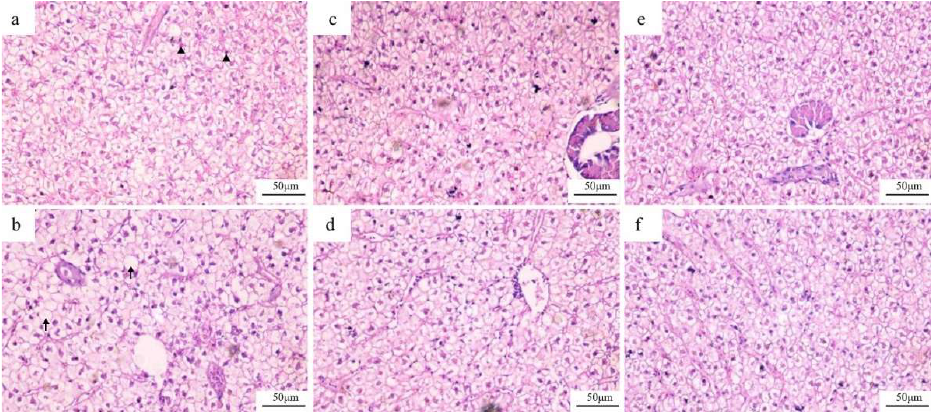
Figure 1. Effect of common reed on liver histology of grass carp (200 times). ( a , b ): 0% replacement group; ( c , d ): 50% replacement group; ( e , f ): 100% replacement group. The triangle in the figure indicates lymphocyte cells, and the arrow indicates vacuolar degeneration of cells. Table 5. Histological parameters of liver from grass carp fed experimental diets. Items